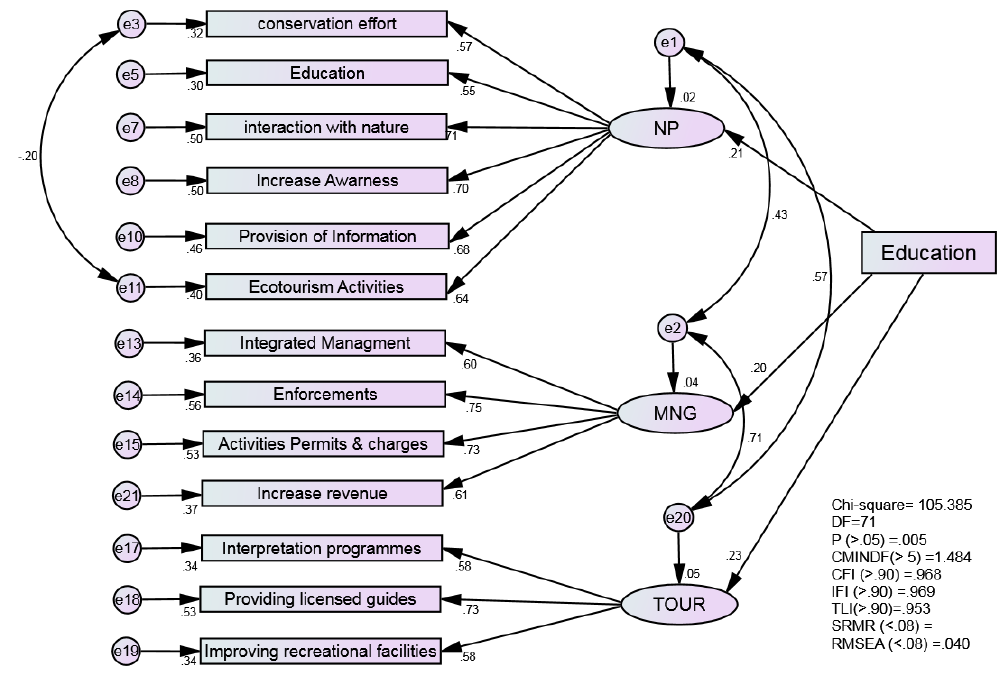
Figure 2. Results of confirmatory factor analysis. All path coefficients shown are completely